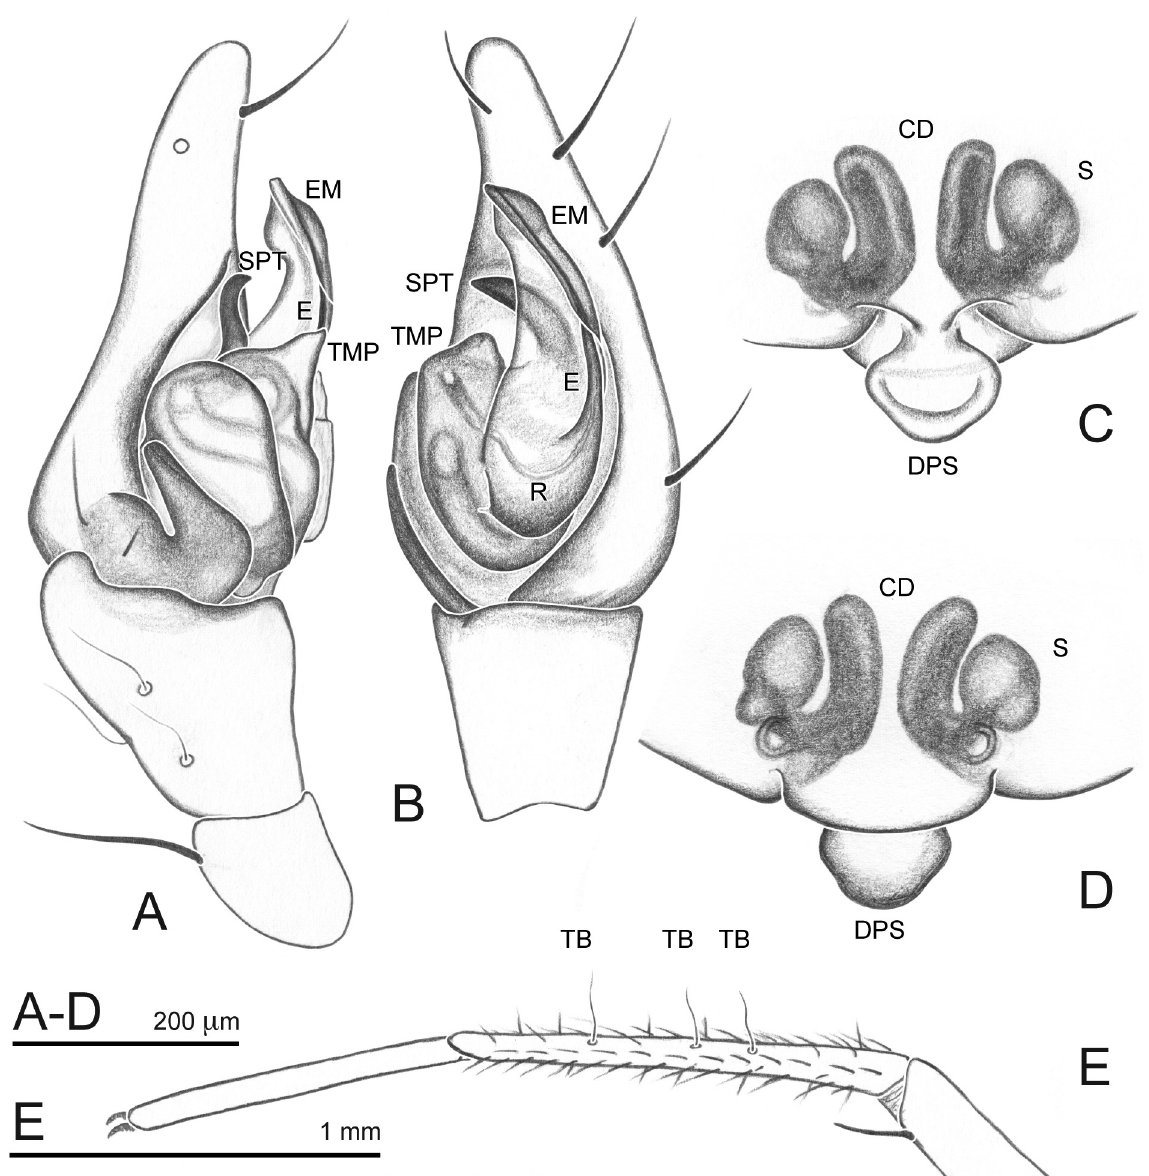
Fig. 1. Camafroneta oku gen. et sp. nov. A–B . Holotype, ♂ (ZMUC00046889) . A . Palp, retrolateral. B . Prolateral. C–D . Allotype, ♀ (ZMUC00046889). C . Epigyne, ventral. D . Vulva, dorsal. E . ♀ (ZMUC00046901) metatarsus 1,